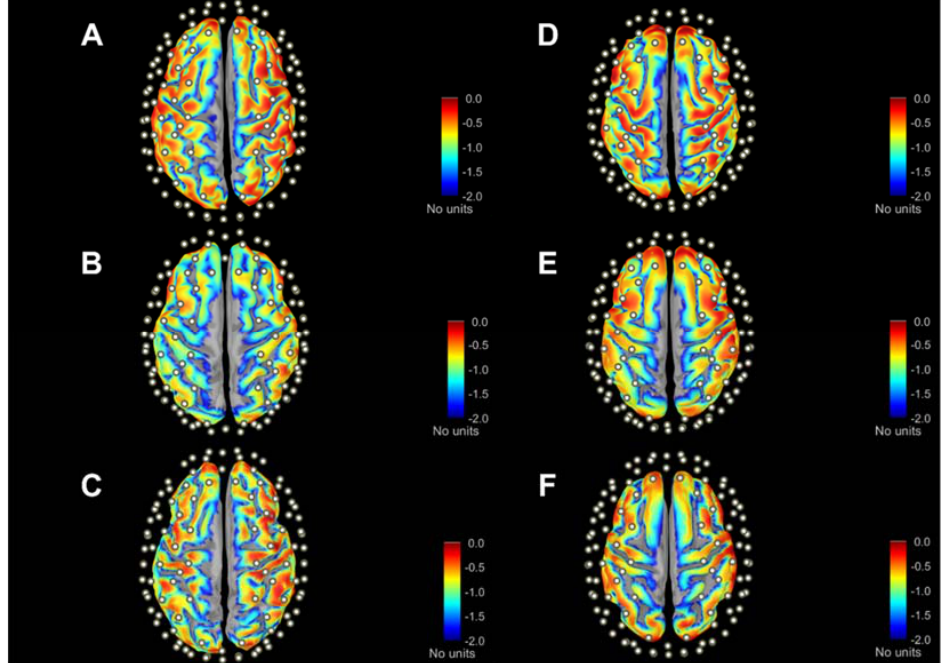
Figure 4. Maps of total sensitivity in three SSAs ( A – C ) and ABAs (( D )—Colin27, ( E )—ICBM152, ( F )—FSAverage) according to anteroposterior direction. Sensitivity values are expressed in log (cid:2869)(cid:2868) (cid:4666)∙(cid:4667) scale. Cortical surfaces are inflated at 40%. All maps refer to λ = 760 nm, while maps for λ = 850 nm are not shown since they display similar patterns.